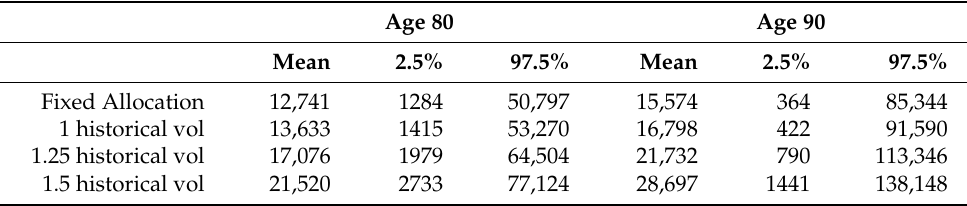
Table 12. Annuity Payments at Different Fixed Target Volatilities at Age 80 and 90.